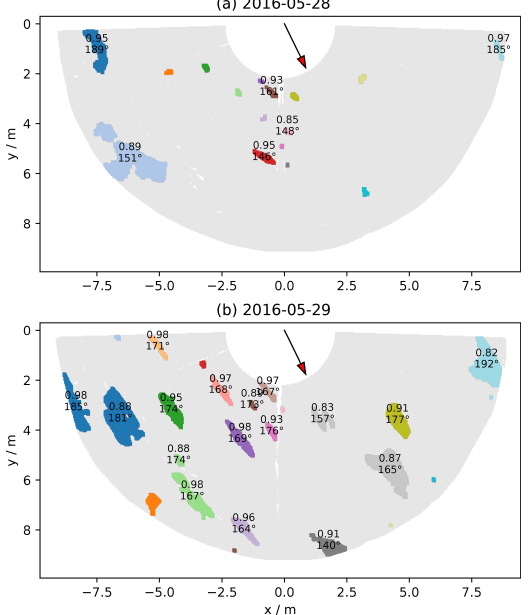
Figure 9. Patches of accumulation ( > 2cm) between 28 and 29 May 2016 (a) and 29 and 30 May 2016 (b) . For each patch with sufficient elongation, the circularity and the orientation are in- dicated. The southern direction (180 ◦ ) is indicated by the red arrow.